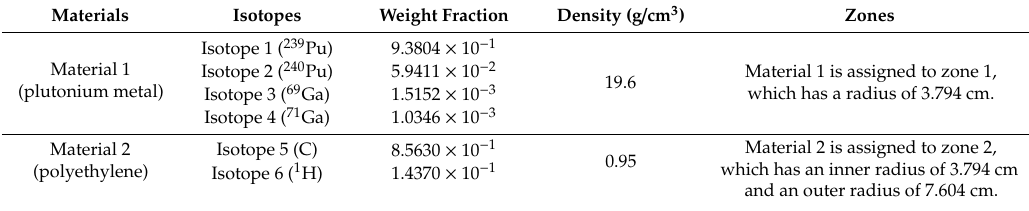
Table 1. Dimensions and material composition of the PERP